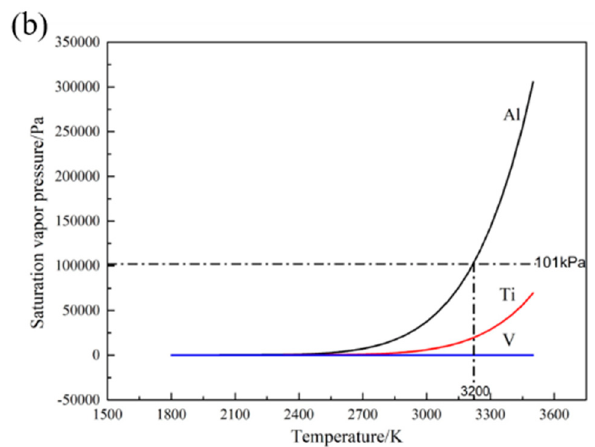
Figure 1. Thermodynamic calculation results of element vaporization: ( a ) the activity coefficient; ( b ) the saturated vapor pressure.